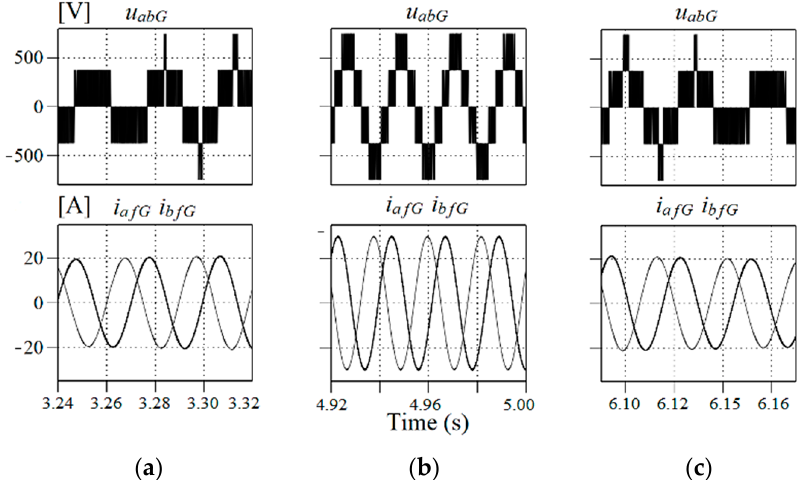
Figure 16. Waveforms of generator voltage u abG , and currents i afG , i bfG at changing ( a ), ( c ) and constant wind speed equal to 11 m/s ( b ).